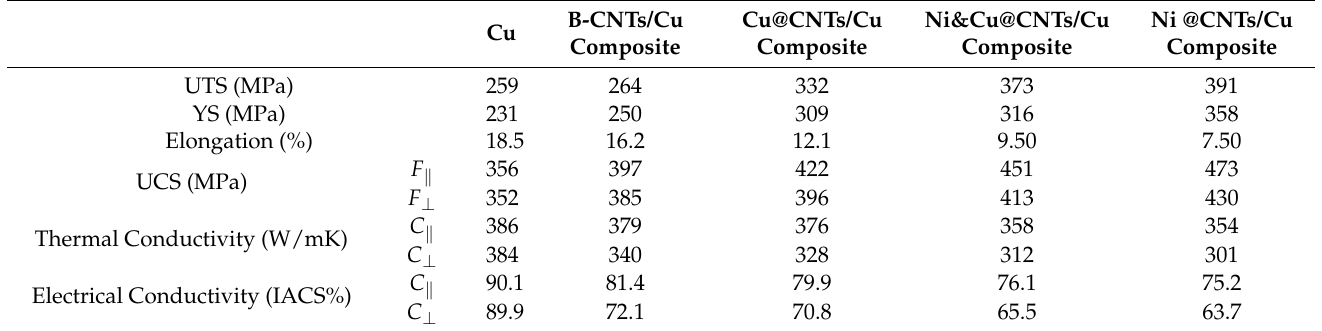
Table 4. Test data of tensile, compressive, and conductive properties of samples. B-CNTs/Cu Cu@CNTs/Cu Ni&Cu@CNTs/Cu Cu Composite Composite